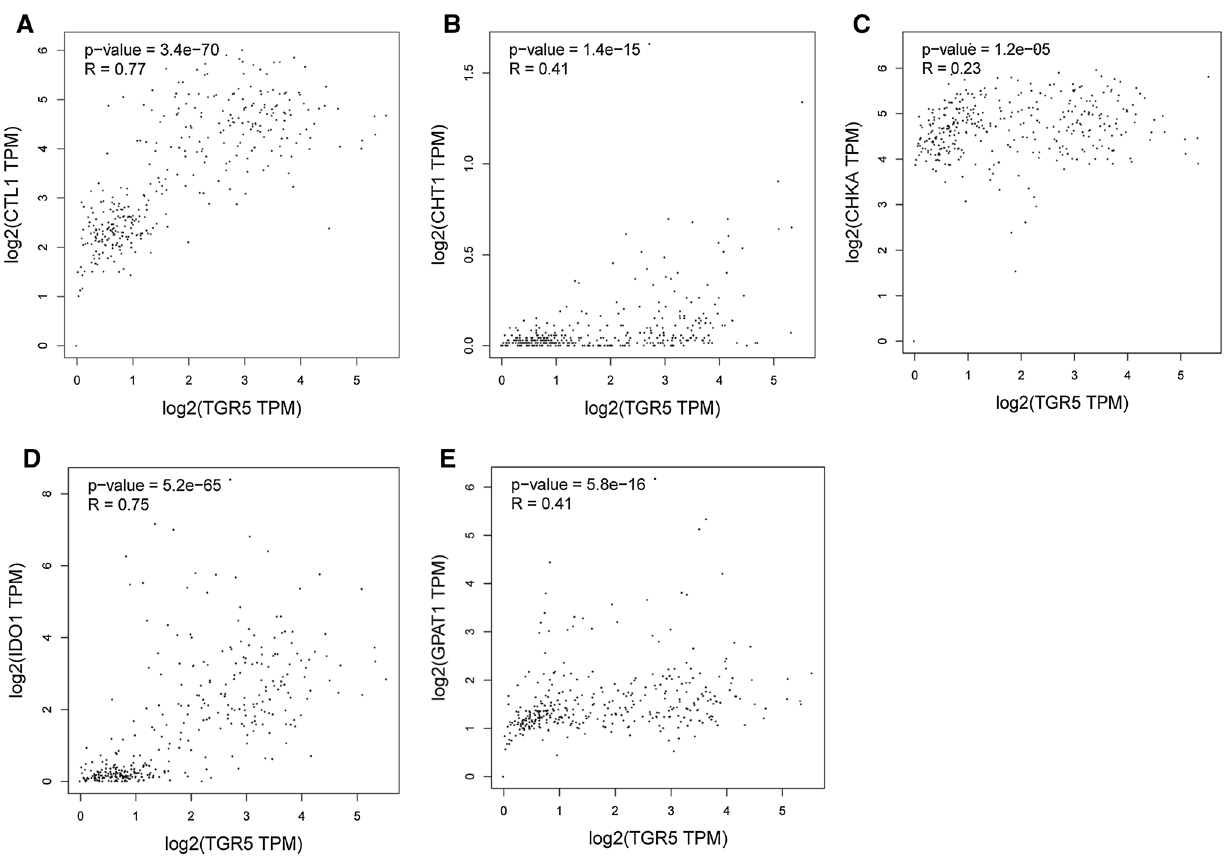
Fig. 7 The correlation analyses between TGR5 and the metabolism-related genes in GEPIA 2. TGR5 exhibited moderate positive associations with CHT1 and GPAT1 (R = 0.41, P < 0.05; R = 0.41, P < 0.05), and TGR5 exhibited strong positive associations with CTL1 and IDO1 (R = 0.77, P < 0.05; R = 0.75, P < 0.05). A CTL1; B CTH1; C CHKA; D IDO1; E GPAT1. CTL1 transporter-like protein 1, CTH1 choline transporter 1, CHKA cho- line kinase alpha, IDO1 indoleamine 2,3-dioxygenase 1, GPAT1 glycerol-3-phosphate